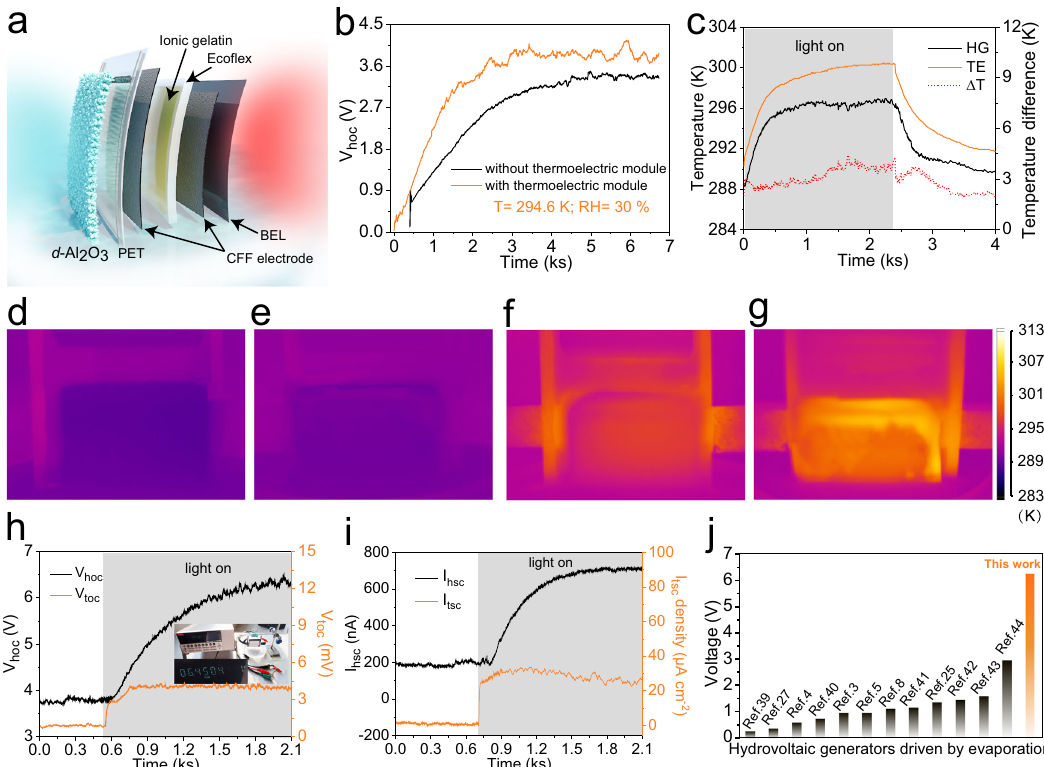
Fig. 4 Proof-of-concept of the HCEHG. a Schematic diagram of the construction of the HCEHG. b Open-circuit voltage response versus time curve of the hydrovoltaic module with and without the thermoelectric module at an ambient temperature of 294.6 K and a humidity of 30% RH. c Real-time temperature change and corresponding temperature difference of the surfaces of the d -Al 2 O 3 fi lm (i.e., HG) and TG module. The ambient temperature is ~290.4 K. Grey areas indicate that the device is illuminated. d , e Infrared thermal images of the d -Al 2 O 3 fi lm surface ( d ) and TG module surface ( e ). f , g Infrared thermal images of the d -Al 2 O 3 fi lm surface ( f ) and TG module surface ( g ) under an optical density of 1 kW m − 2 . The ambient temperature is ~290.4K. h Real-time V hoc and V toc changes of the hydrovoltaic module and thermoelectricity module under one sun irradiation, respectively. The size of the hydrovoltaic module is 5 × 3 cm 2 (width × height). Grey areas indicate that the device is illuminated. i Real-time I hsc and I tsc density changes of the hydrovoltaic module and thermoelectricity module under one sun irradiation, respectively. Grey areas indicate that the device is illuminated. j Maximum voltage generated by single HG driven by